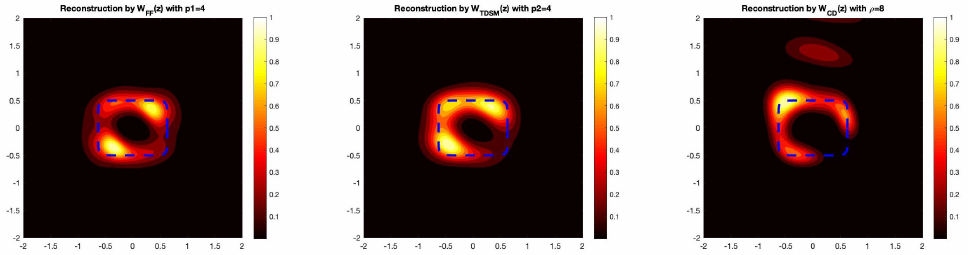
Figure 6. The reconstruction of the rounded square with 3/4 partial aperture data, i.e., measurements only taken on θ j ∈ [ 0,3 π /2 ) . In this example, we take δ = 0.05 which corresponds to a 5% noise level.